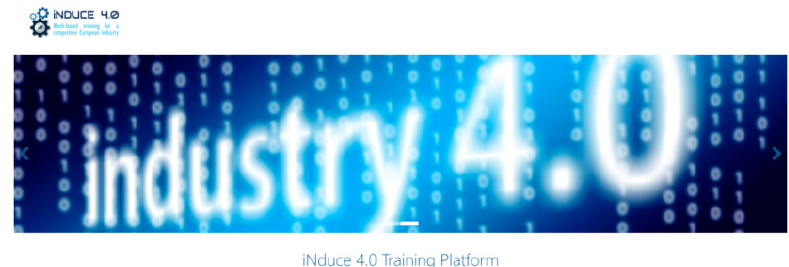
Figure 1. iNduce 4.0 e-learning platforms.